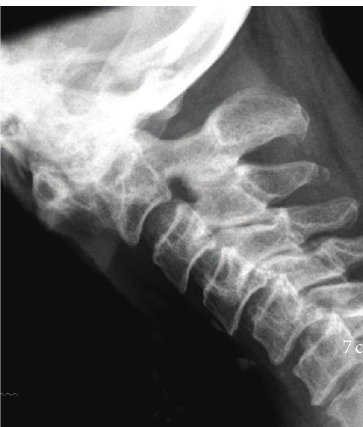
Figure 3: Lateral cervical radiograph of a patient demonstrating AA subluxation in flexion.